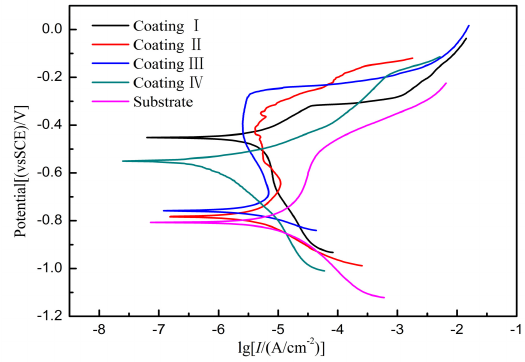
Figure 15. Potentiodynamic polarization of substrate and coatings with different